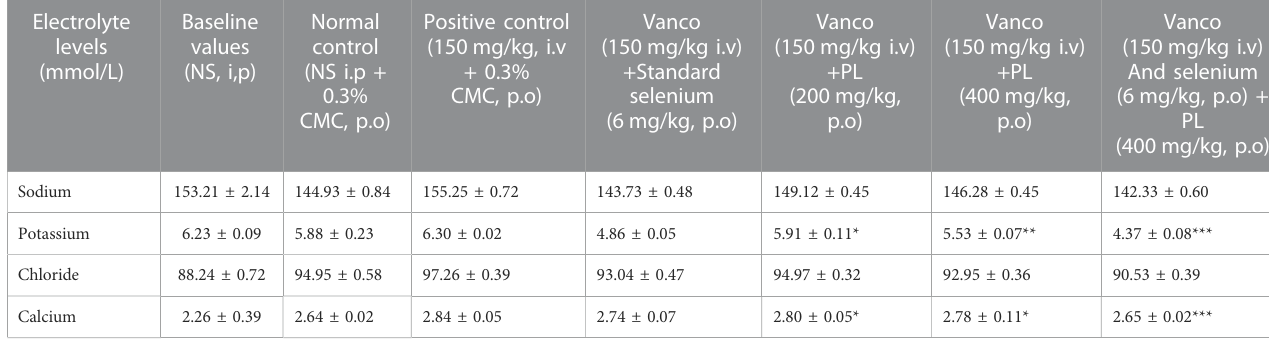
TABLE 2 Effect of curative administration of PL and selenium on blood electrolyte levels in rats treated with vancomycin. Electrolyte